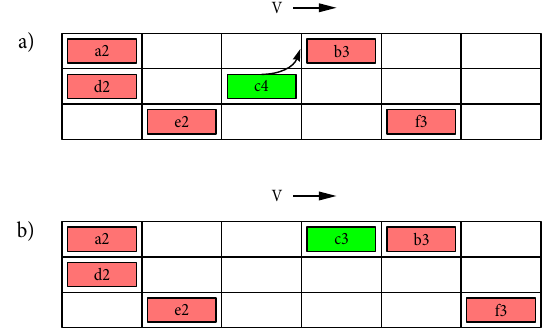
Fig. 4. Sketch maps of lane-changing in the guidance compliance scenario from t to t